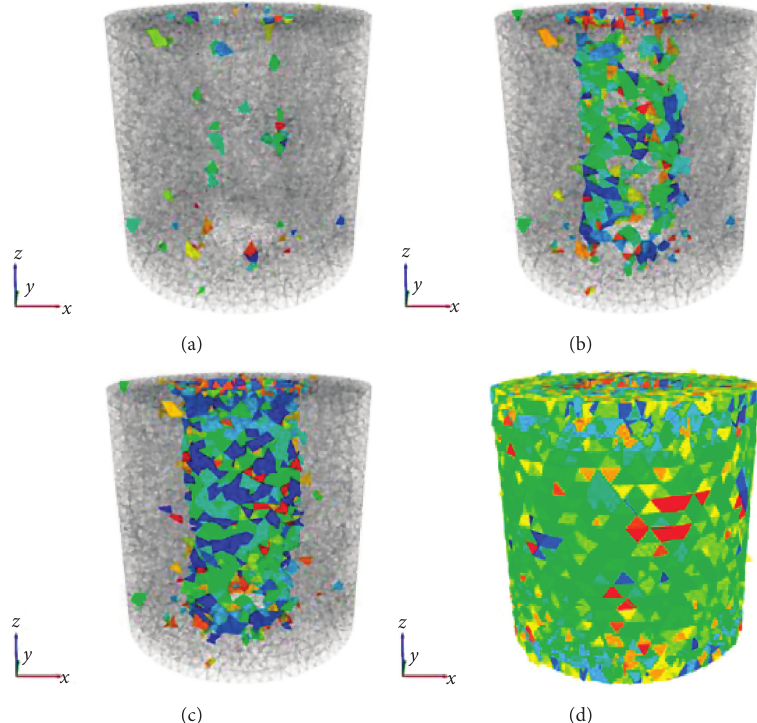
Figure 8: Perspective view of the rock fragments at four different states for the TWC test with intact rock sample (the colored blocks represent failed rock fragments, while the grey line segments in the plots illustrate the outlines of the unfailed blocks).